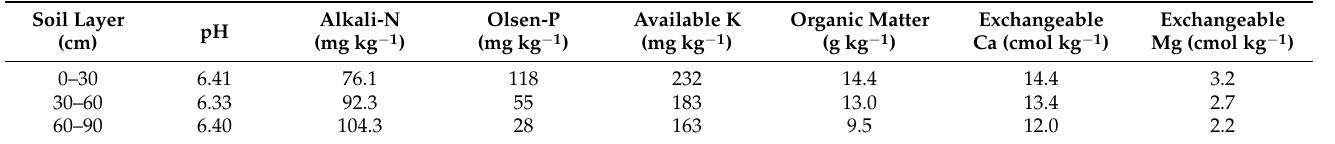
Table 1. Soil characteristics at the experimental